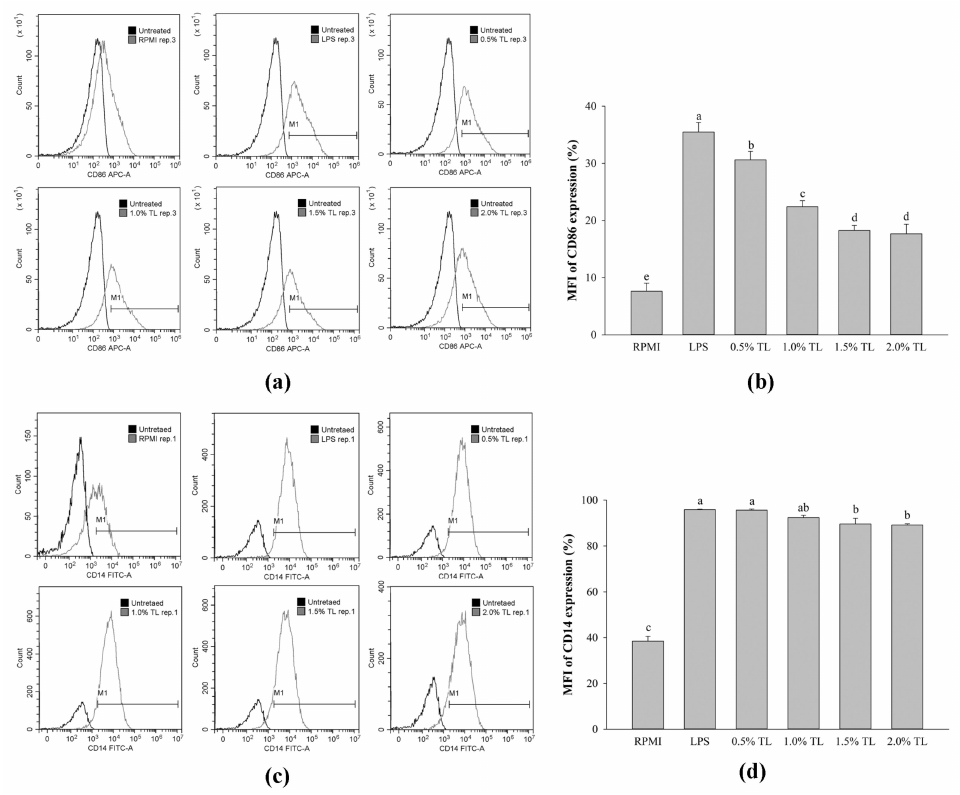
Figure 5. The effects of lipid extracted from A. personatus eggs on the expression of cell surface molecules. ( a ) Representative flow cytometry analysis of CD86 expression; ( b ) MFI of CD86 expression; ( c ) representative flow cytometry analysis of CD14 expression, and ( d ) MFI of CD14 expression. Data are presented as means ± standard deviation ( n = 3). The letters a, b, c, d, and e indicate significant differences ( p < 0.05) between treatment groups. M1 = classically activated macrophage phenotype (related to immune stimulation activity) and TL = total